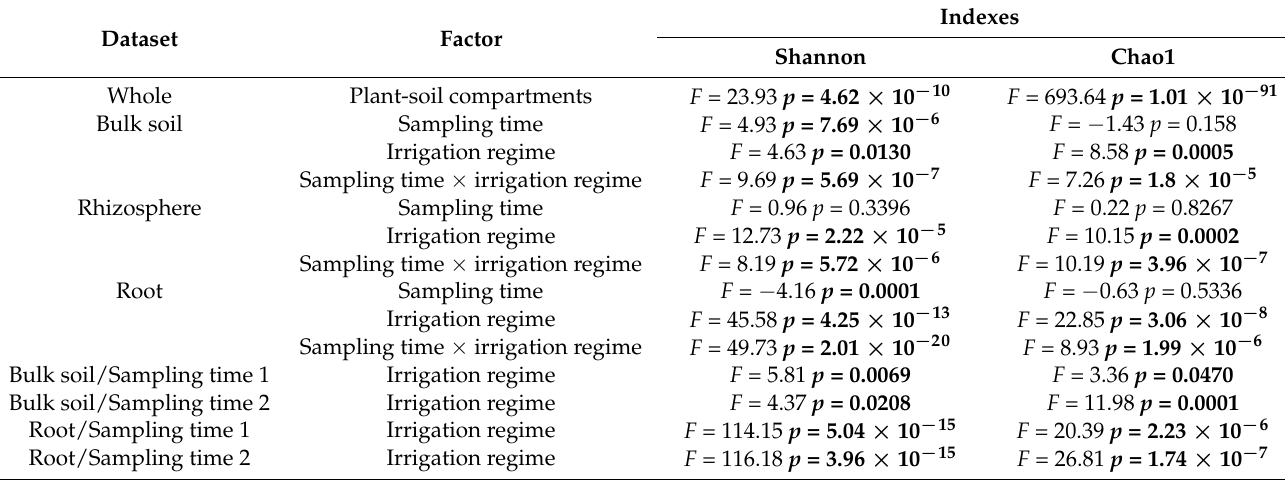
Table 1. Experimental factors predicting alpha diversity of bulk soil-, rhizosphere- and root-associated fungal communities. Dataset